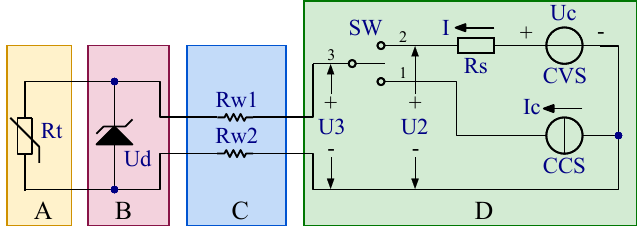
Figure 1. Circuit schematic for the lead-wire-resistance compensation technique.